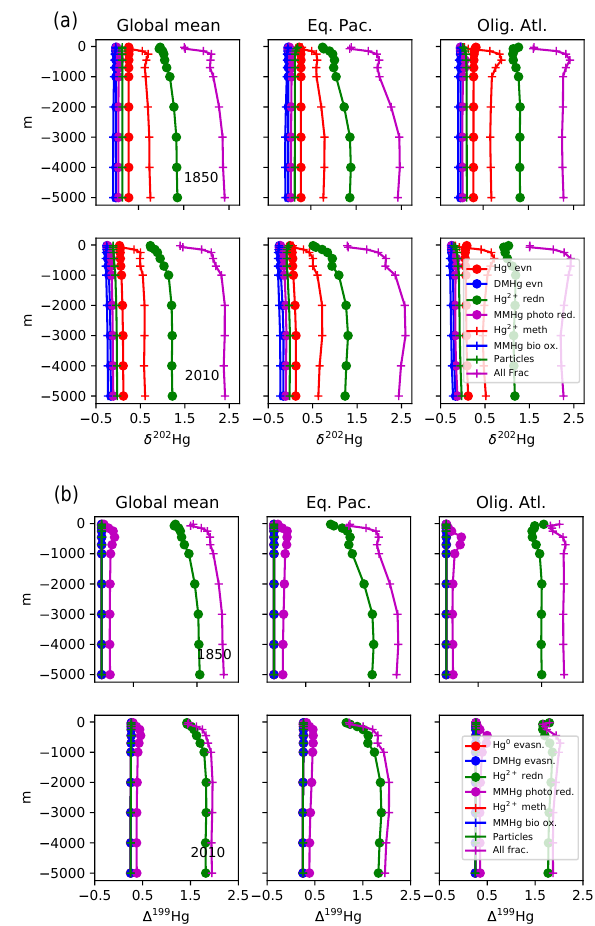
Figure 12. Profiles of δ 202 Hg(II) and (cid:49) 199 Hg(II) for different frac- tionation scenarios: global mean and for the locations in Fig. 4.